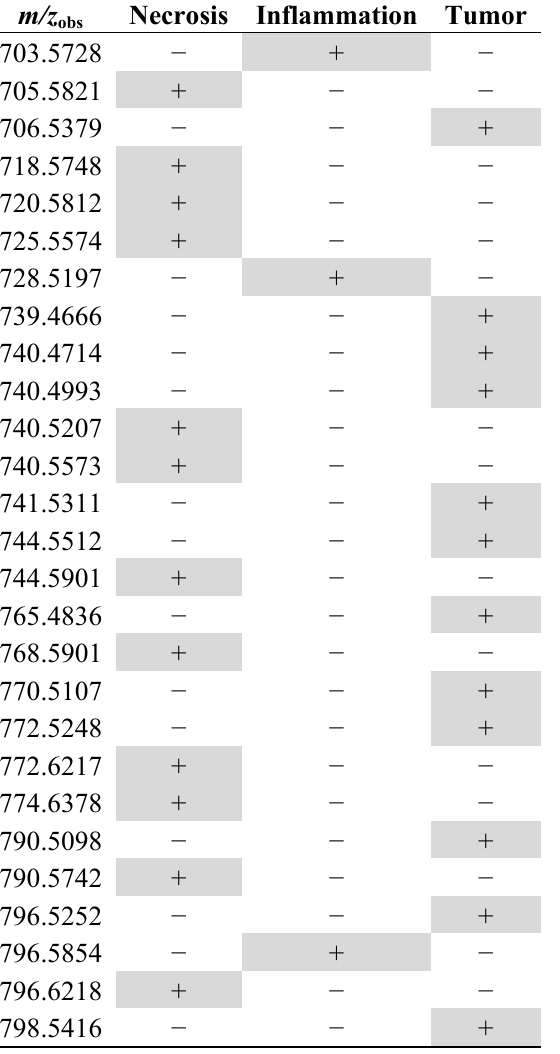
Table 1. Low-abundant PL species associated with one specific tumor area detected during MALDI MSI analyses. Grey highlighted (+) corresponds to the localization of the PL species in tissues.